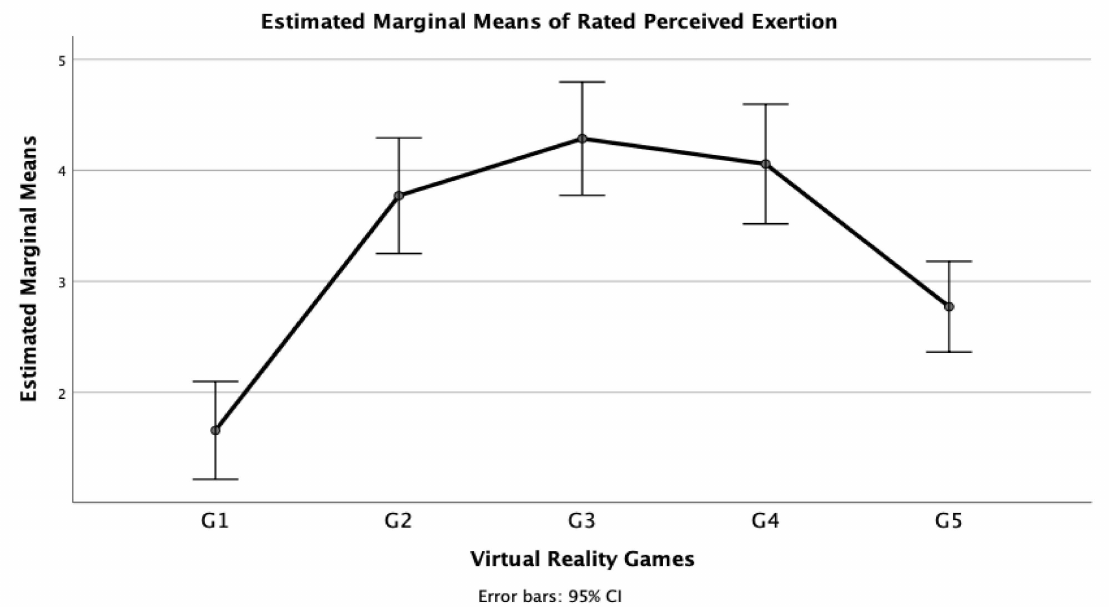
Figure 1. Variation in games’ rated perceived exertion across a complete rehabilitation session to recover from musculoskeletal